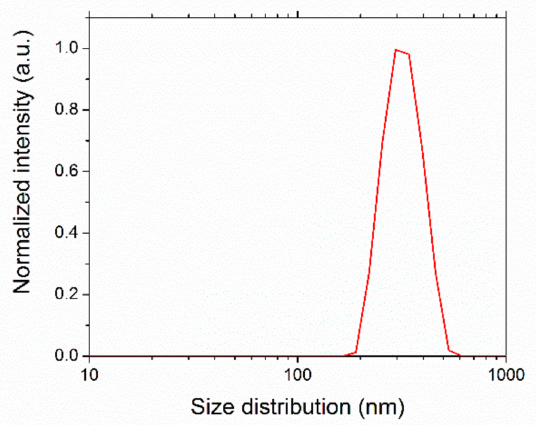
Figure 2. Size distribution measured on the sample with 0.13 g/L